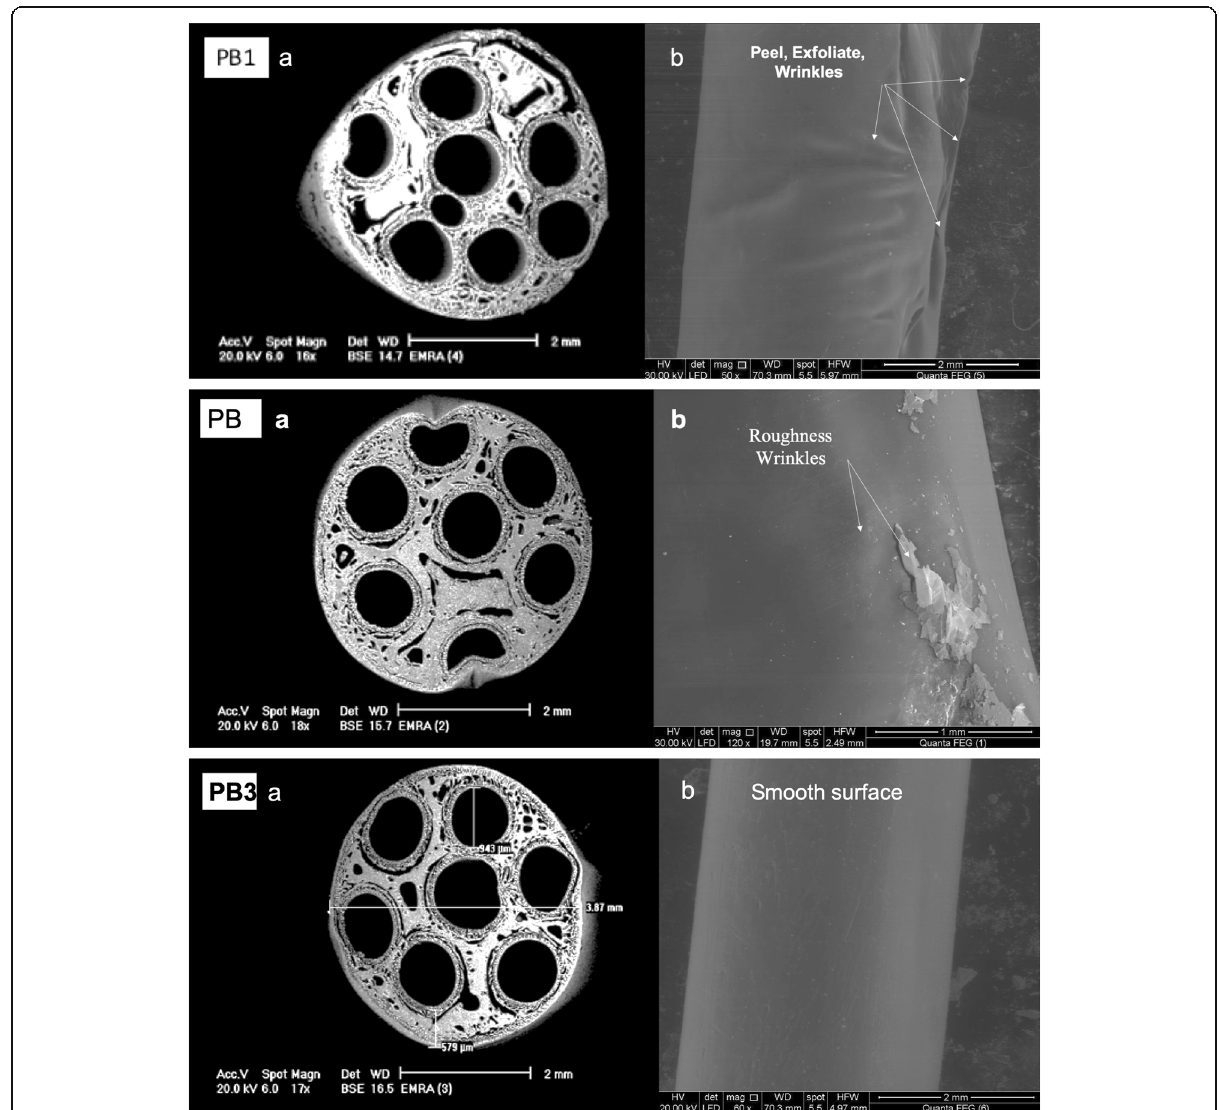
Fig. 9 SEM images of circular (seven-bore hollow fiber) membrane at different dope blend